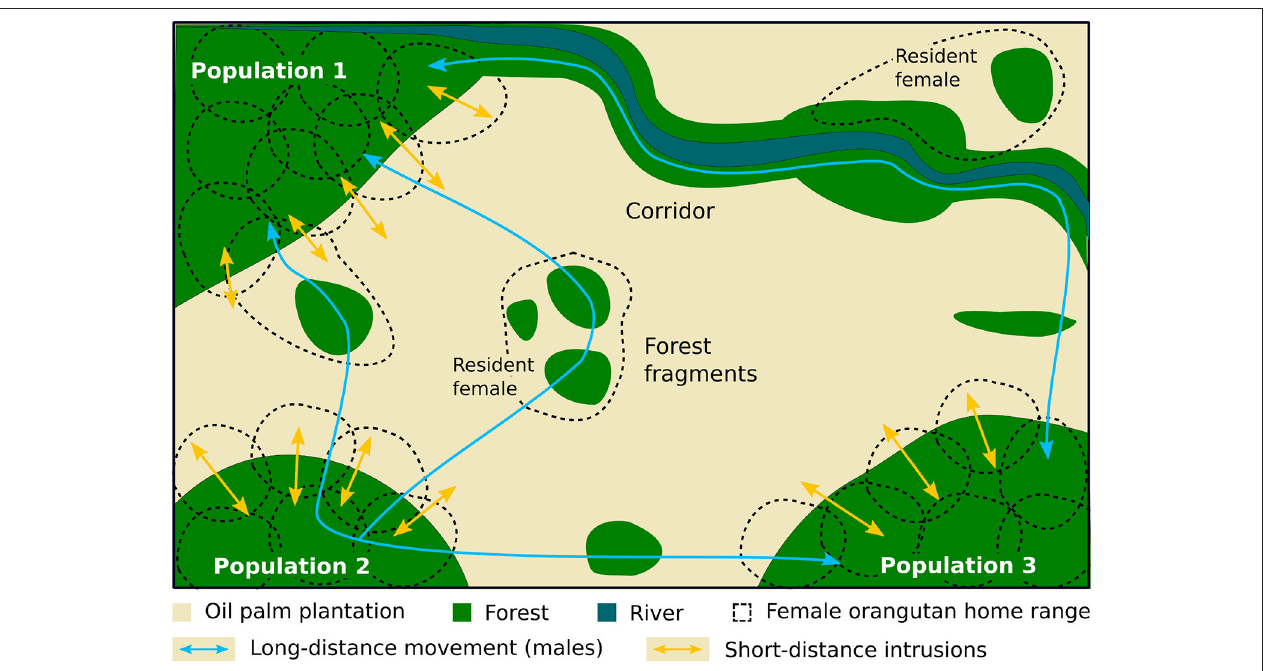
FIGURE 1 | Diagram showing the ranging pattern and ranging dynamic of wild orangutans in a fragmented